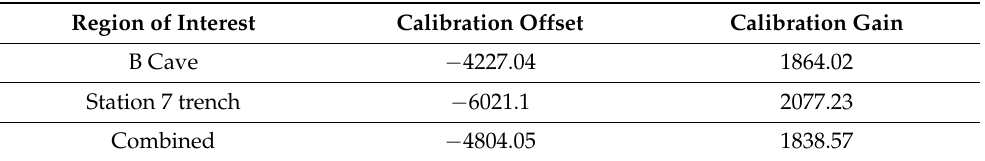
Table A2. Calibration coefficients from 2010 experiments [69] to roughly match observations and assumptions. Calibration offset has been increased by 4500 DN from Titus et al.